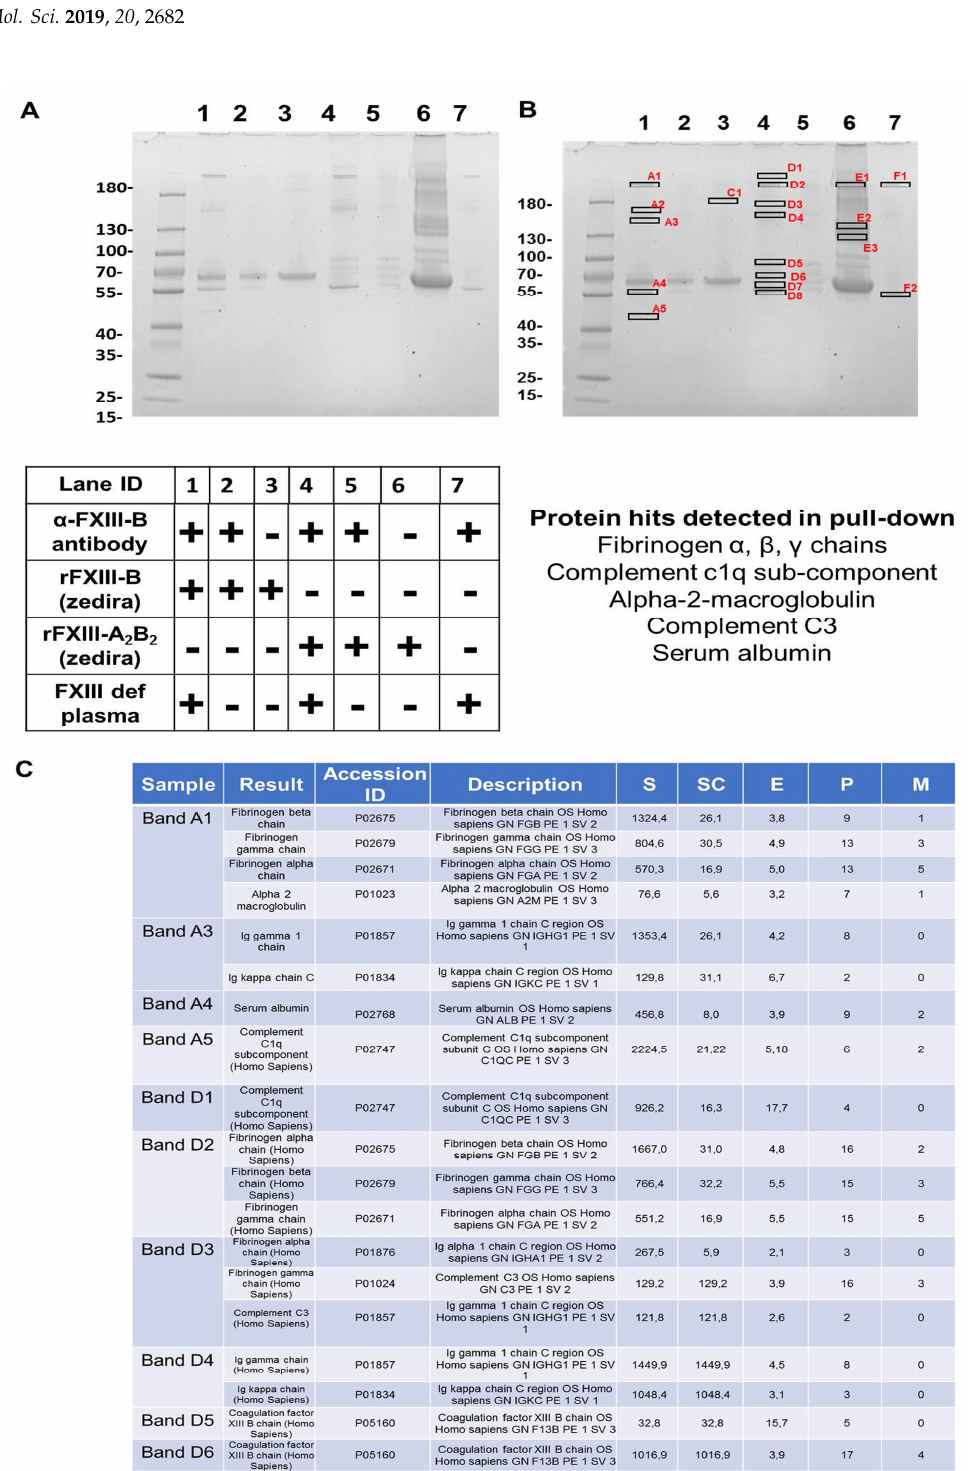
Figure 4. Interactome analysis of FXIII-B in FXIII-DP by Co-immunoprecipitation. ( A ) Coomassie stained SDS-PAGE gel for the proteins pulled down by resin immobilized FXIII-B (bound through amine-linked monoclonal antibody). Table below shows the experimental conditions. ( B ) Shows the same SDS-PAGE as in Panel A, but with those bands that were subsequently analysed for proteomic content by mass spectrometry individually marked (data in Supplementary Figure S2). The major hits are listed at the bottom of this panel, as well as in ( C ). ( C ) Table representing the majority of protein hits obtained by MS analyses of excised bands indicated in B. For a detailed protein-hit summary refer Supplementary Information. Abbrev: S: Protein Score; SC: Sequence coverage in %, E: Mean mass error in ppm; P: number of identified peptides; M; number of modified peptides interactome